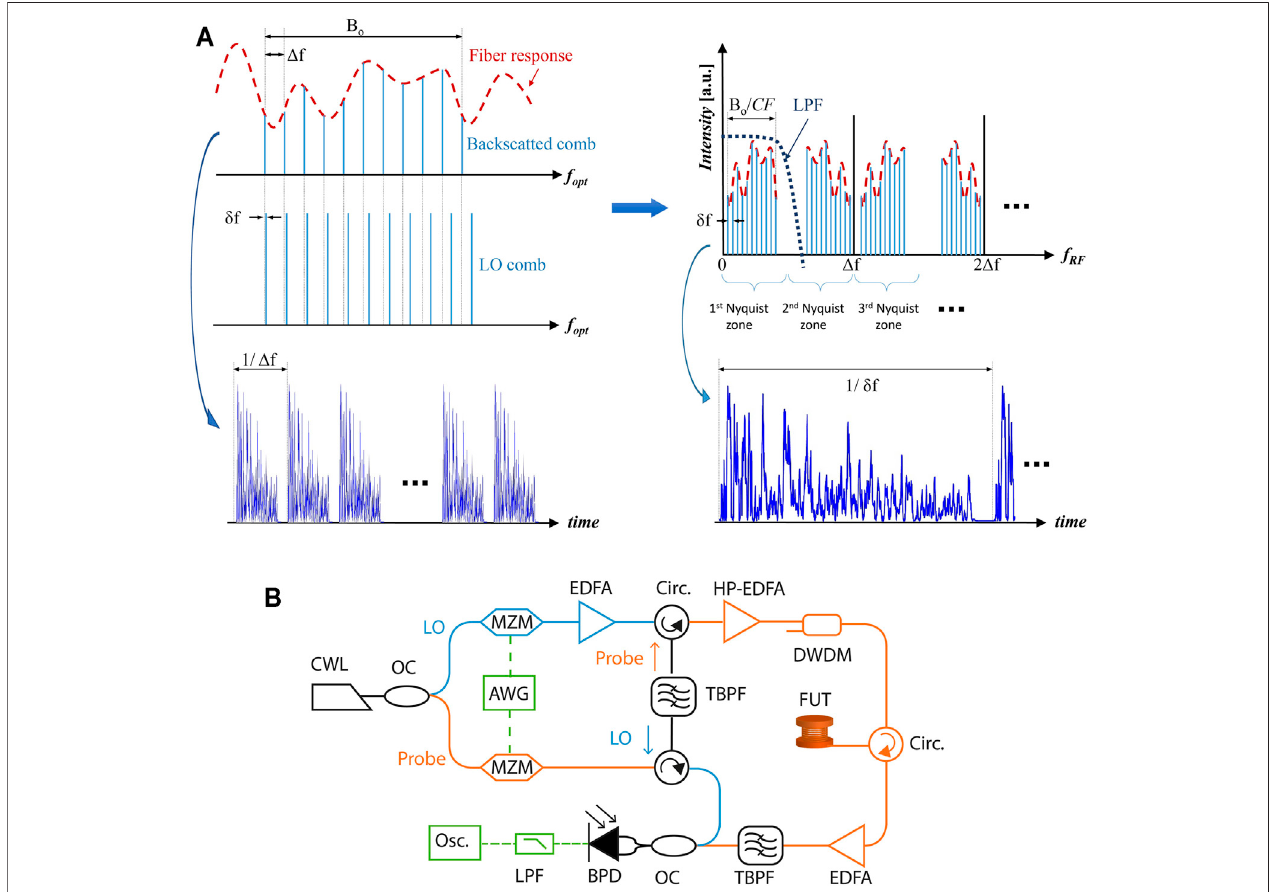
FIGURE 1 | (A) Principle of operation of TE- Φ OTDR. Upon interference of the backscattered and local oscillator (LO) optical combs, pairs of RF combs appear within each line space interval in the electrical domain. By fi ltering the comb located in the fi rst Nyquist zone, we obtain in time domain a time-expanded trace providing information on the fi ber response. LPF: Low pass fi lter. Comb parameters are de fi ned in the manuscript. (B) Experimental setup of a TE- Φ OTDR scheme. Acronyms: CWL:continuous wavelaser;OC: opticalcoupler; LO:localoscillator;MZM:Mach-Zehndermodulator;AWG: arbitrary waveform generator; EDFA: erbium-doped fi ber ampli fi er; TBPF: Tunable band pass fi lter; Circ: circulator; HP-EDFA: high-power EDFA; DWDM: dense wavelength division multiplexer; FUT: fi ber under test; BPD: balanced photodetector; LPF: low-pass fi lter; Osc: Oscilloscope.